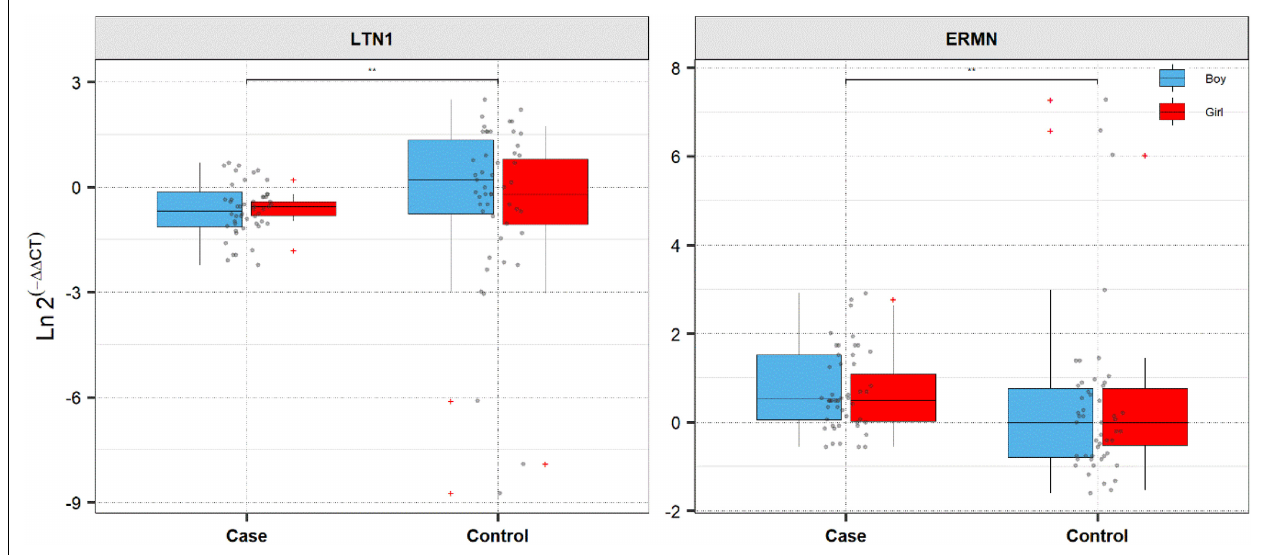
FIGURE 1 | Expression of ERMN and LTN1 in cases and controls’ blood samples. Ln (Efficiency (cid:49) Ct ) method was used to calculate expression levels of genes, and the values are depicted as black dots. Means of expression levels and interquartile range are displayed.